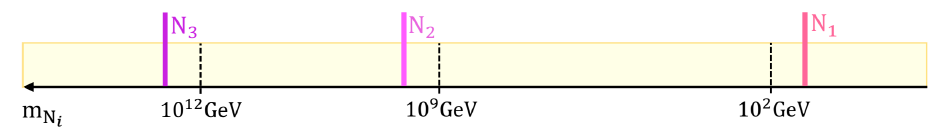
Figure 8 . For concreteness we assume this hierarchical mass spectrum for right-handed neutrinos. The mass of N is specified by the relic density of DM in section 1